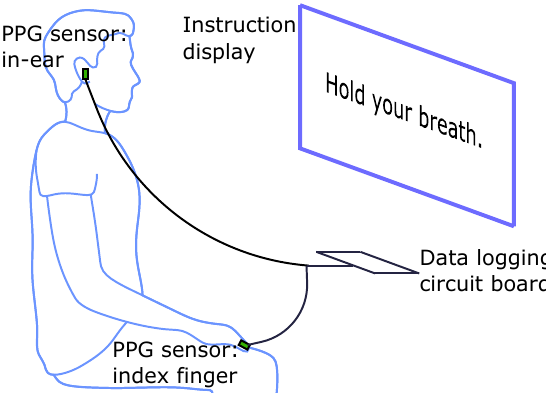
Figure 2. Simultaneous photoplethysmography (PPG) recording from the ear canal and finger. One PPG sensor is placed in the right ear canal, and another is attached to the right index finger. The simultaneous recordings are linked via a circuit board which logs the respective data streams on SD cards. The subjects are instructed on when to breathe normally, exhale and hold their breath via a video played on a monitor (see Figure 3 for the protocol), with a built in countdown to reflect the elapsed time in each phase.